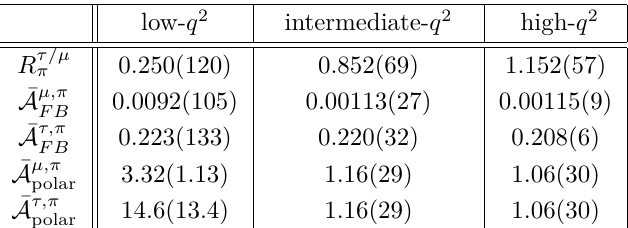
, the normalized forward- π ( K ) evaluated polar decays with ‘ = µ, τ adopting ‘